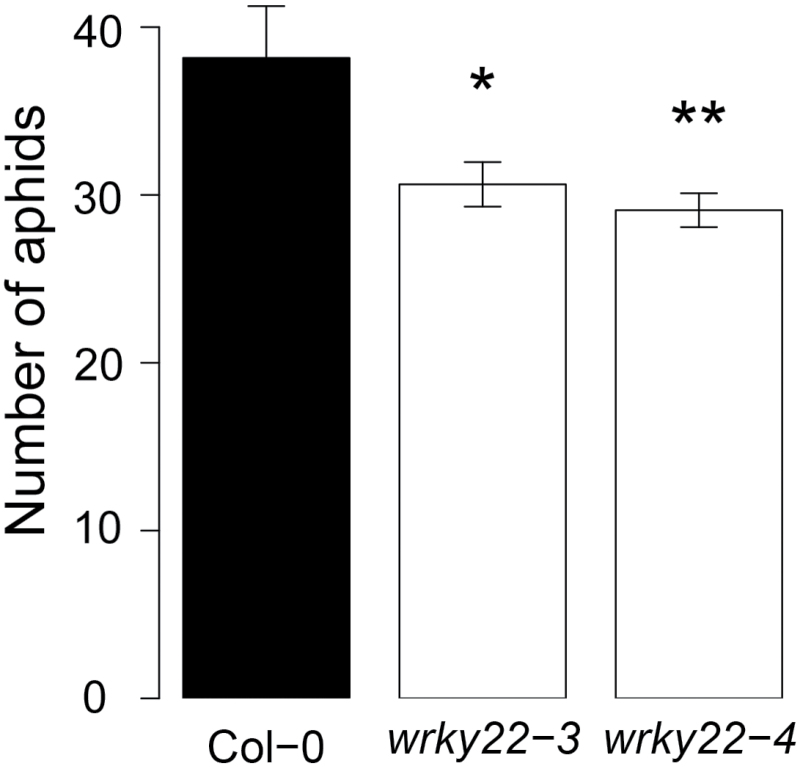
Aphid population size on wild-type and knockout plants. The total number of M. persicae aphids per plant was counted 2 weeks after infestation with one neonate aphid. Mutant lines were compared with the wild-type with Student’s t-test (*P<0.05; **P<0.01).